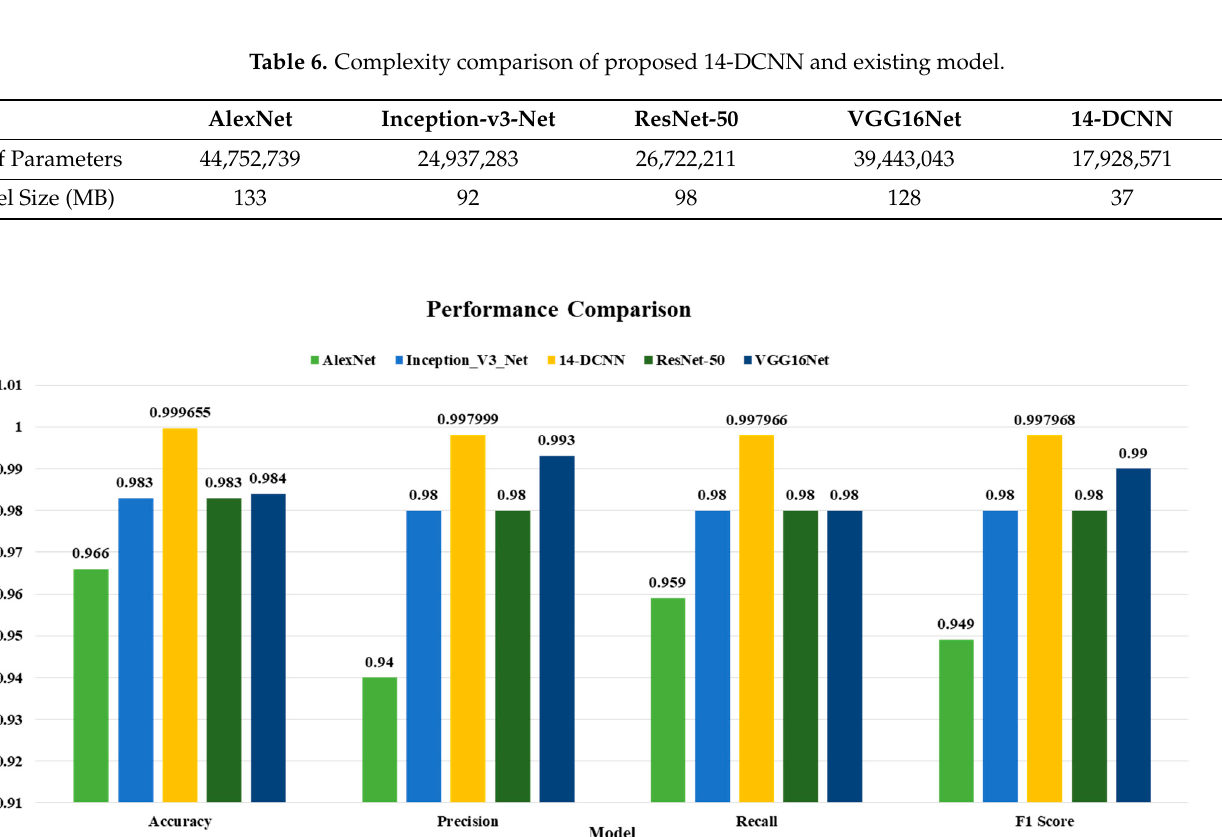
Table 6. Complexity comparison of proposed 14-DCNN and existing model.